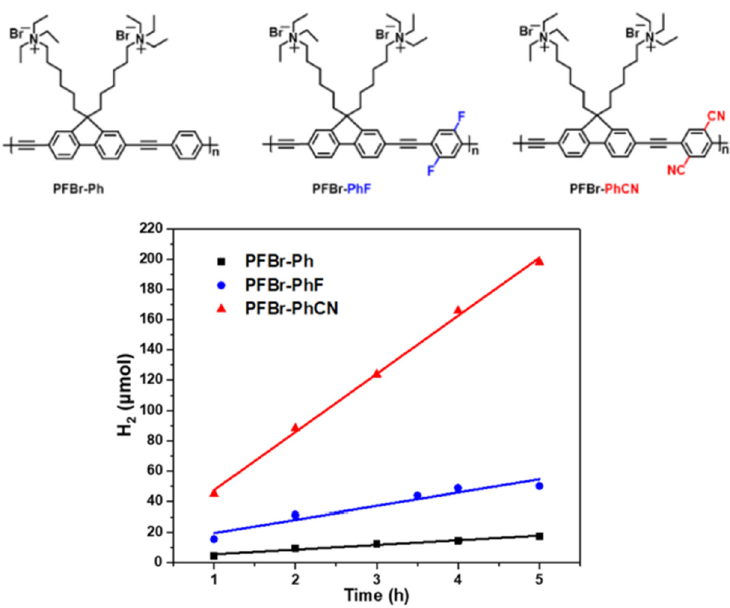
Figure 19. Top : Structures of three CPEs; Bottom : The corresponding hydrogen evolution data (0.2 M ascorbic acid, pH 4, 3% Pt cocatalyst, under broadband irradiation) [Adapted with permission from [111]. Copyright 2019 American Chemical Society].